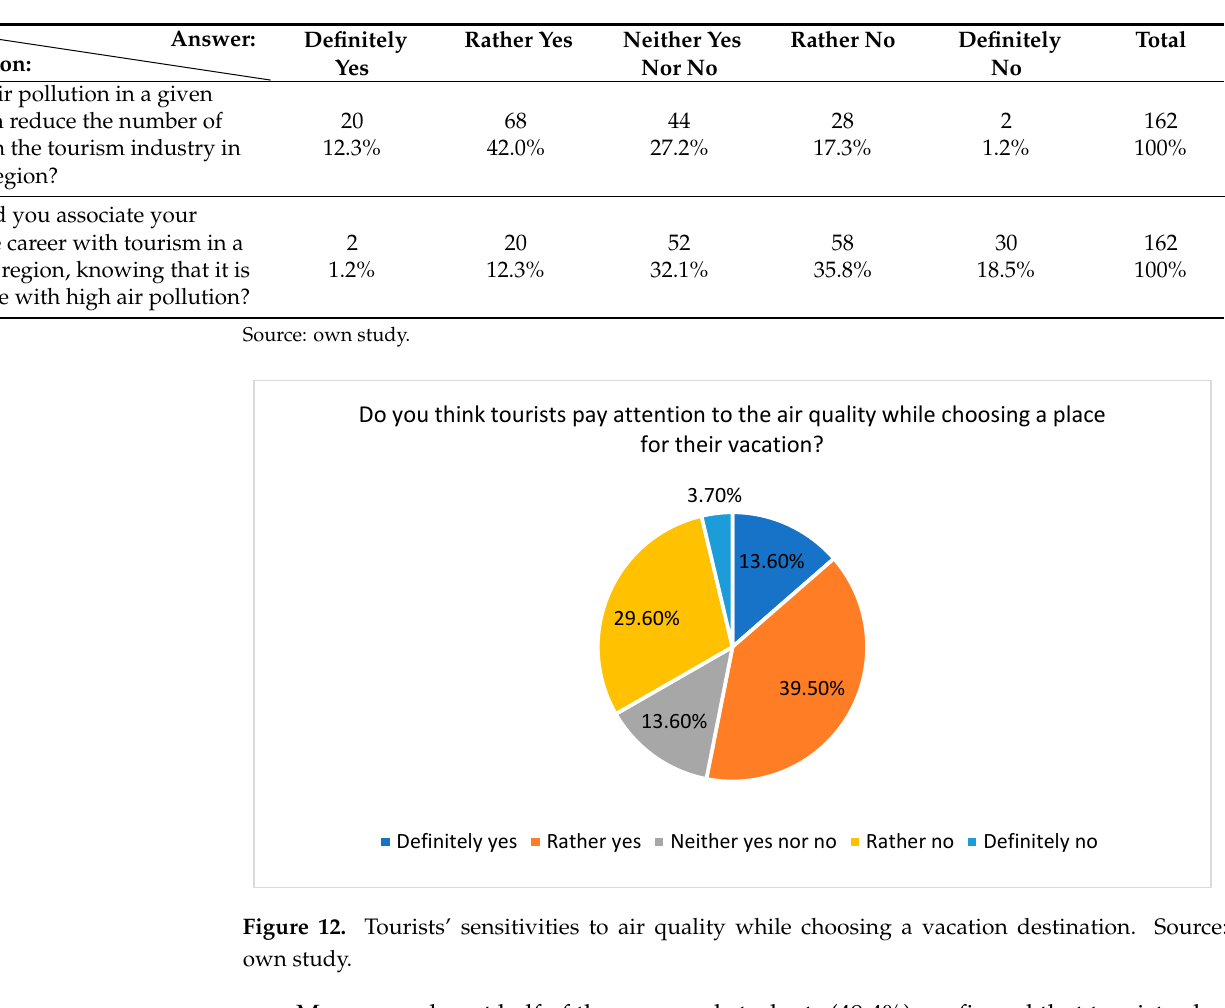
Table 5. Consequences of air pollution for career perceptions in the T&H industry.